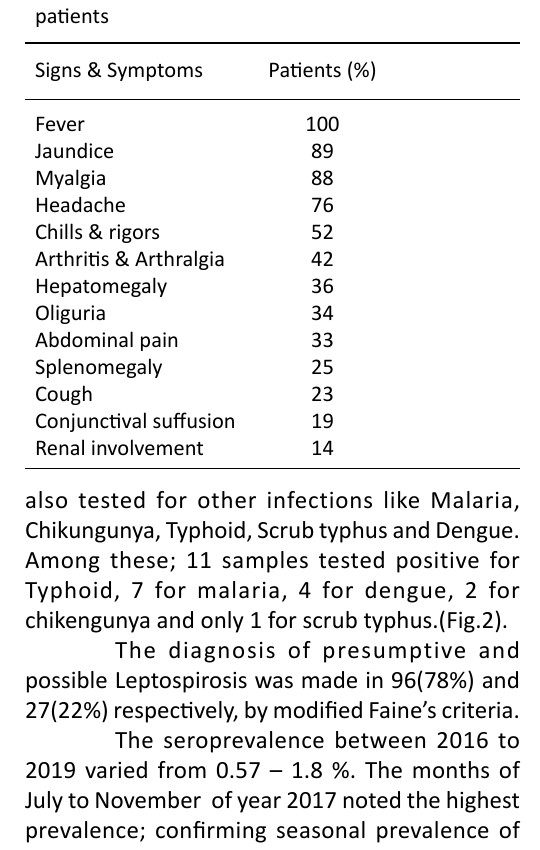
Table 1. Distribution of Signs & Symptoms in the